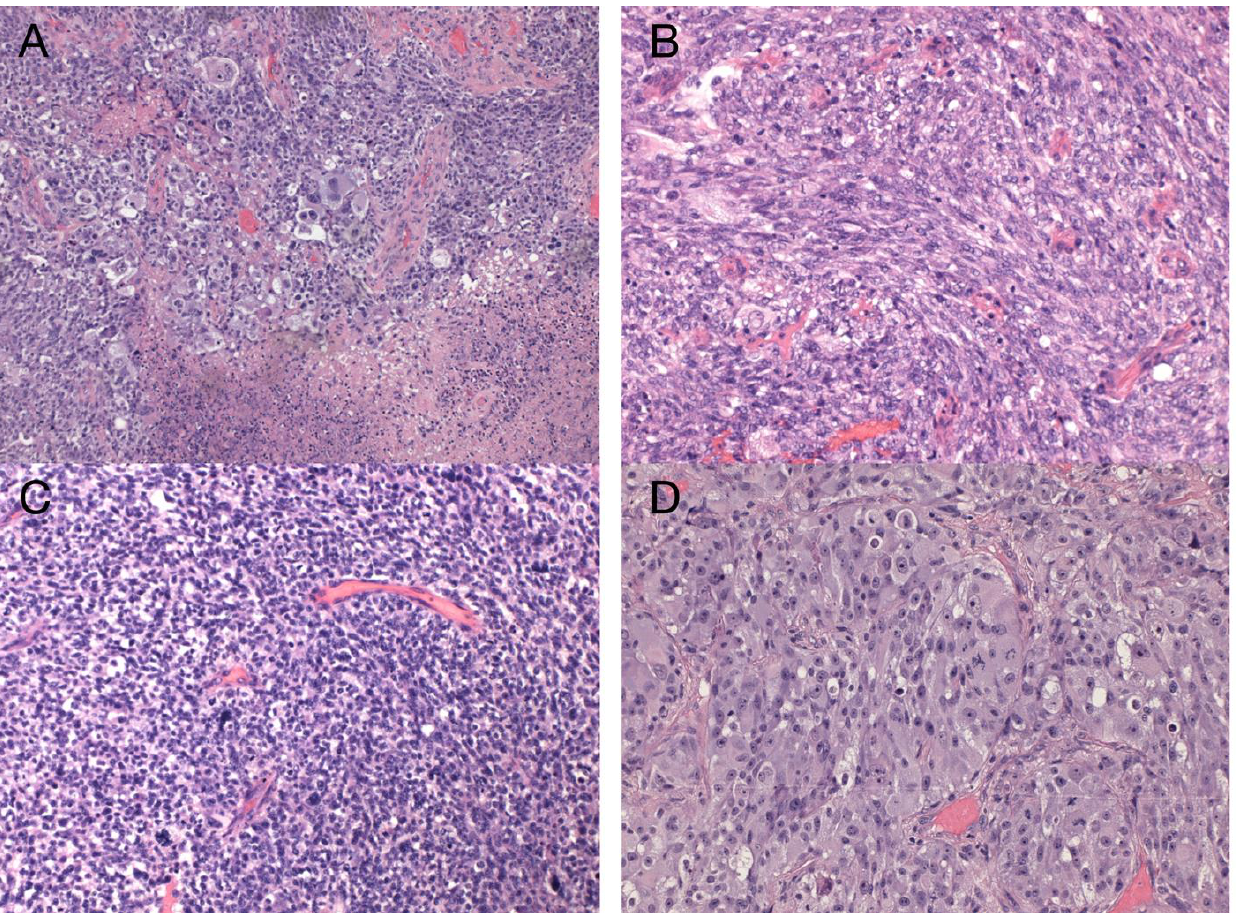
Figure 2. Histology of the primary GBM. Hypercellular high-grade diffuse glioma featuring significant cellular pleomorphism, including multinucleated giant cells, nuclear atypia, brisk mitotic activity, multiple microvascular proliferations, and necroses ( A ) (original magnification 100×). Regions with spindle cell morphology ( B ), small round blue cell morphology corresponding to regions of PNC ( C ), and epithelioid morphology ( D ) (original magnification 200×).